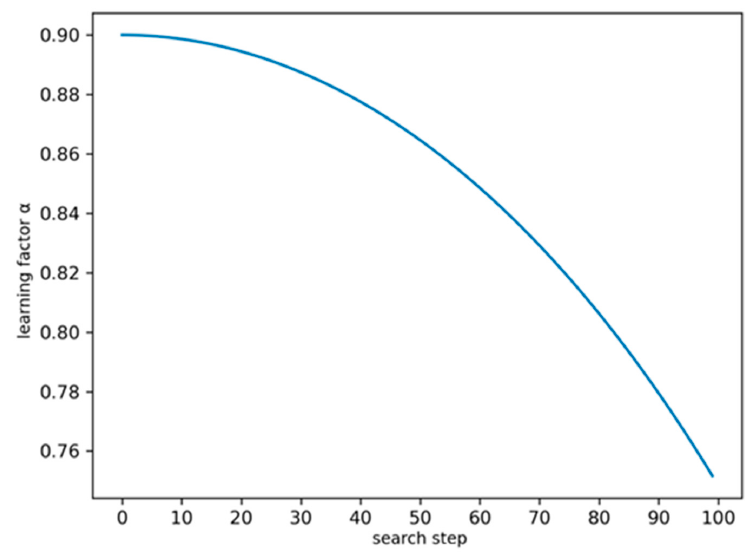
Figure 12. Learning Factors α Dynamic Change Curve with Training Step.